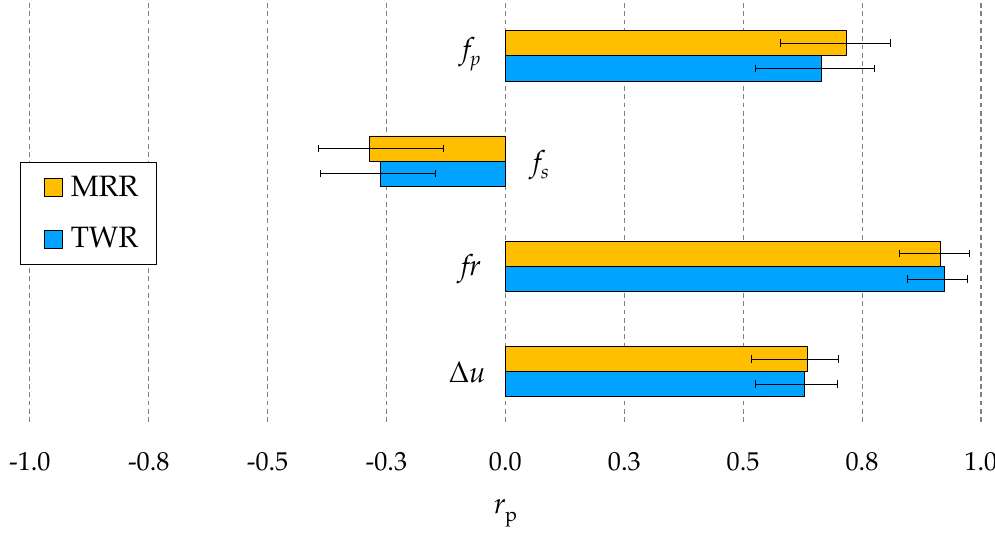
Figure 6. Pearson’s correlation coefficients ( r p ) of the four potential indicators for the process fingerprint with respect to the material removal rate (MRR) and tool wear rate (TWR). Mean values and ranges of the four experimental repetitions are shown.